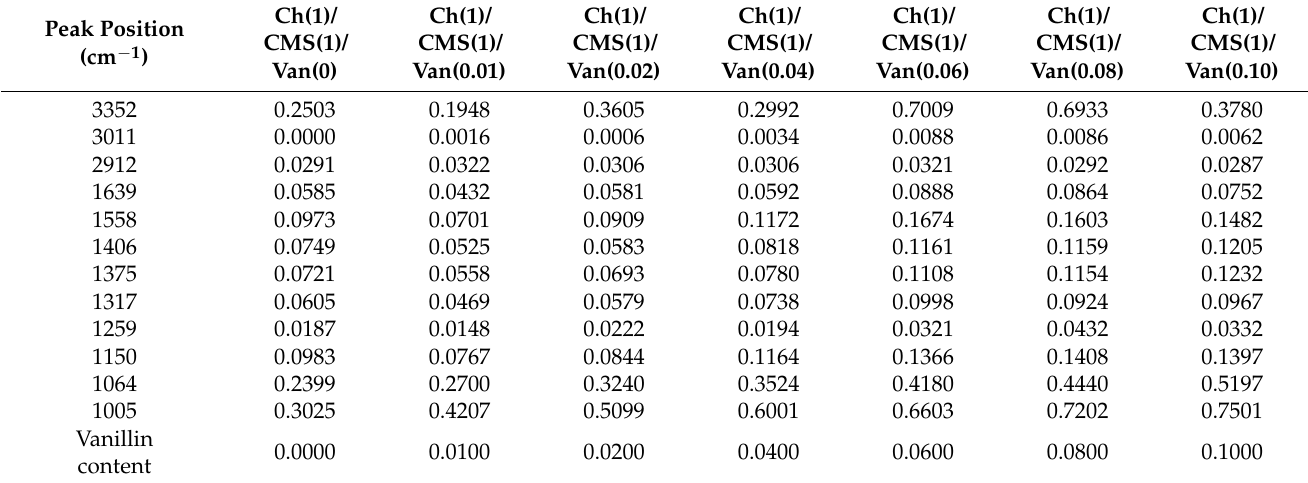
Table 1. The intensity of important bands in the FTIR spectra of studied polymers.